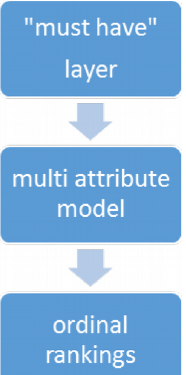
Figure 8. Process flow for location attractiveness